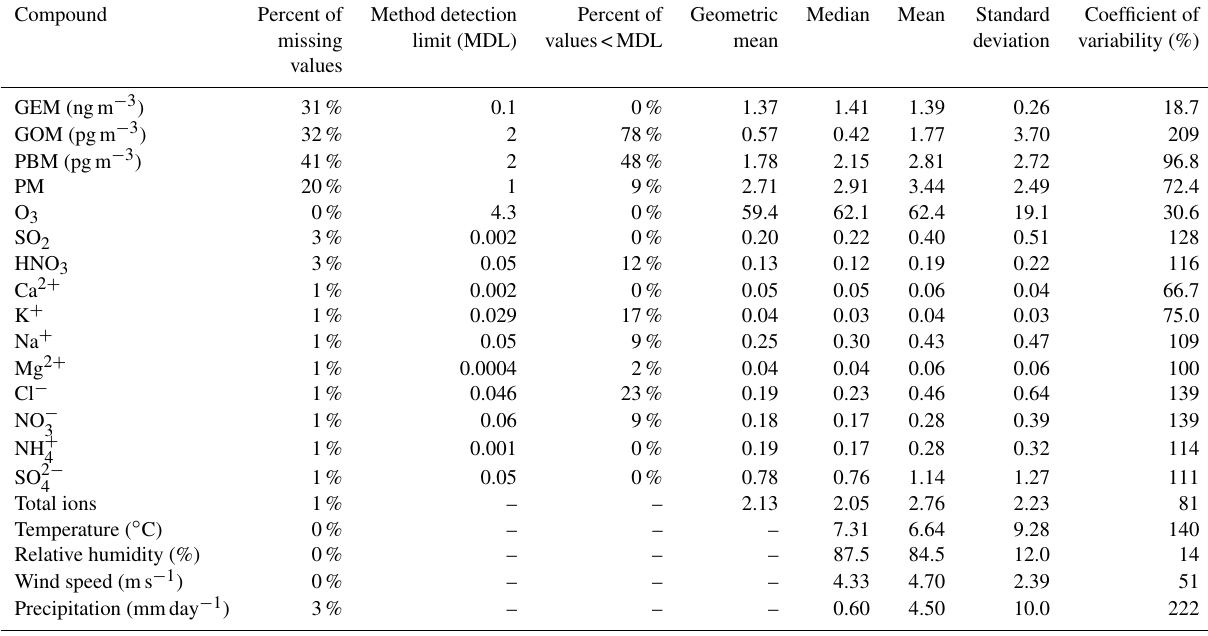
Table 1. General statistics of daily air pollutant concentrations (in µgm − 3 unless otherwise noted) and meteorological parameters in 2009.